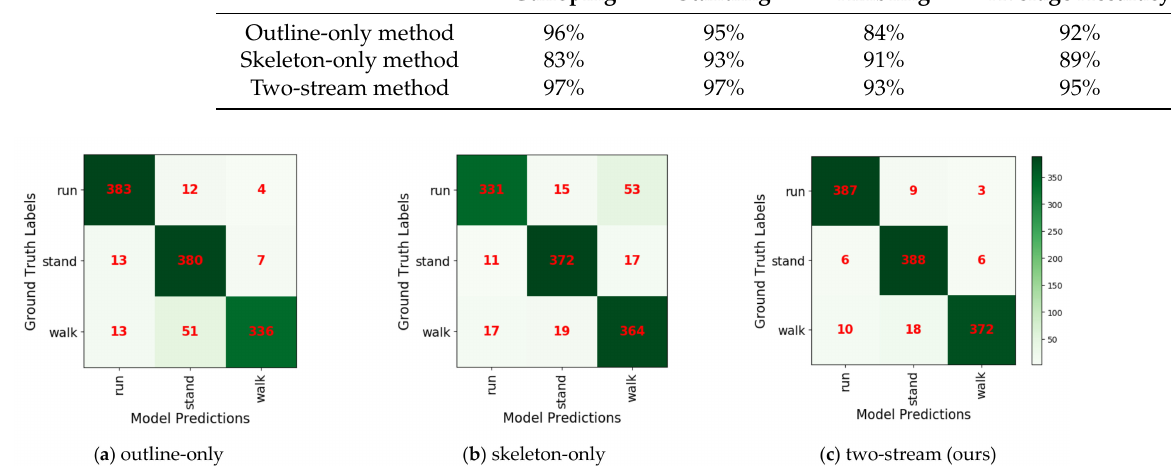
Figure 13. Confusion matrix for the three proposed models: all correct predictions are located on the diagonal of the matrix; it is easy to visually inspect the number of feline actions with incorrect predictions, as they are represented by values outside the